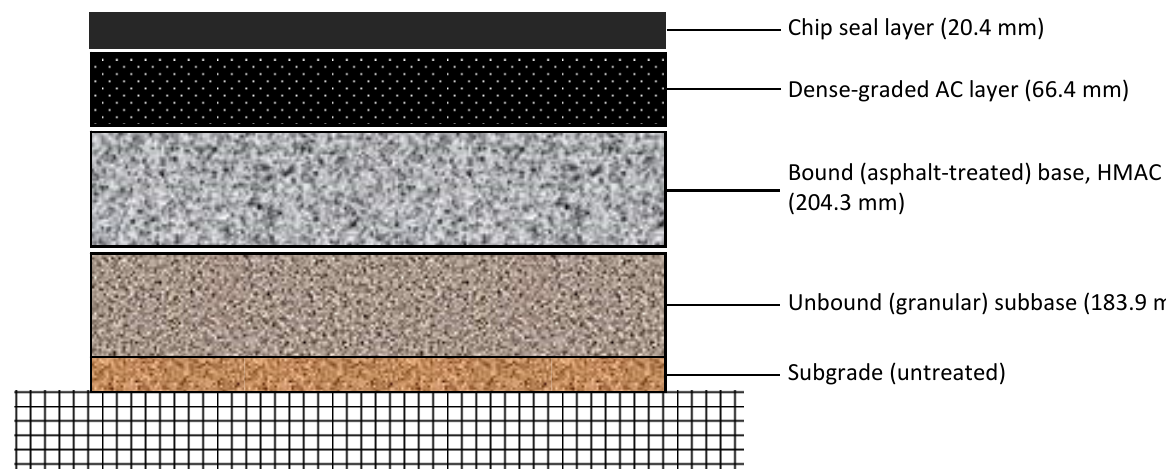
Figure 2. Pavement cross-section of LTPP test section 36-A350 (not in scale; data source: [33]).